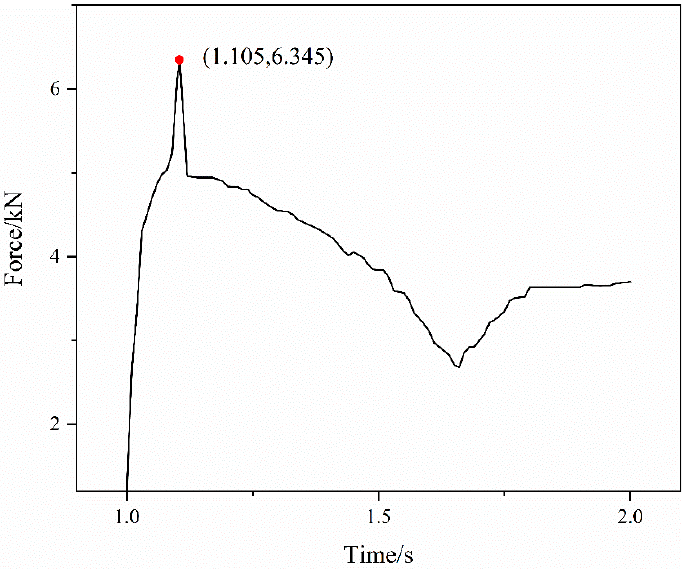
Figure 12. The variation curve of the pulling force on the titanium tube.